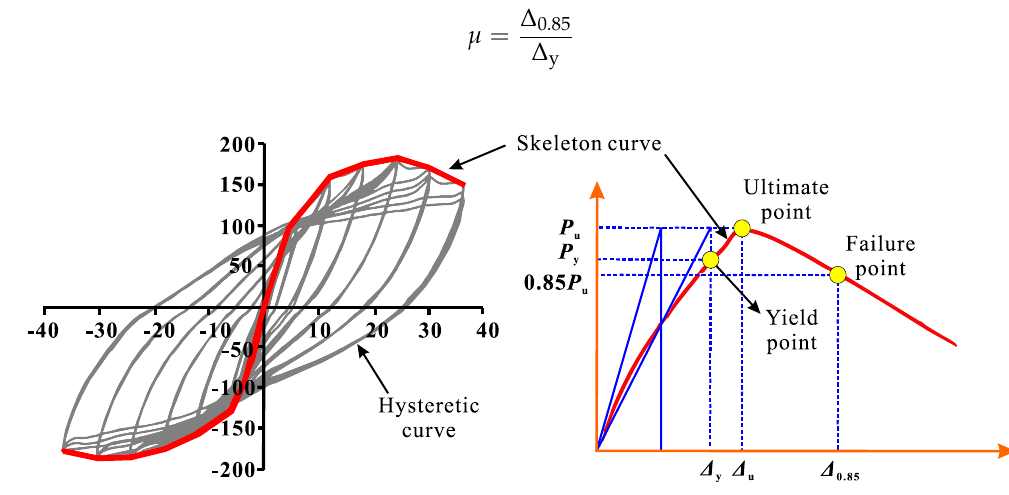
Figure 5. Load-displacement backbone curve.